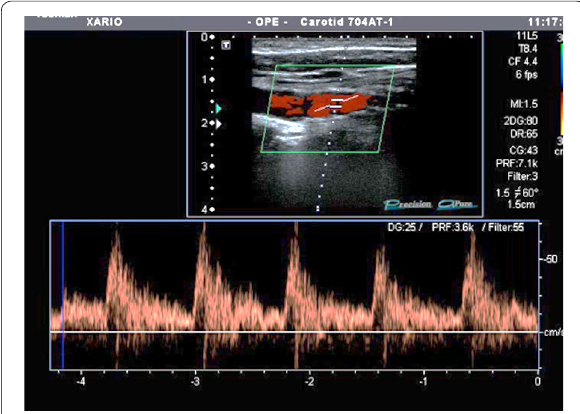
Fig. 7 Color and pulsed Doppler demonstrating restored normal flow in common carotid artery at the site of the